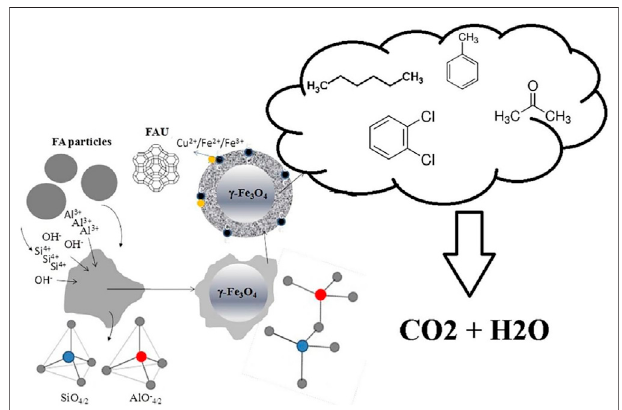
FIGURE 2 | Schematic diagram of zeolite prepared from fl y ash and its catalytic performance for VOCs (Boycheva et al., 2019).